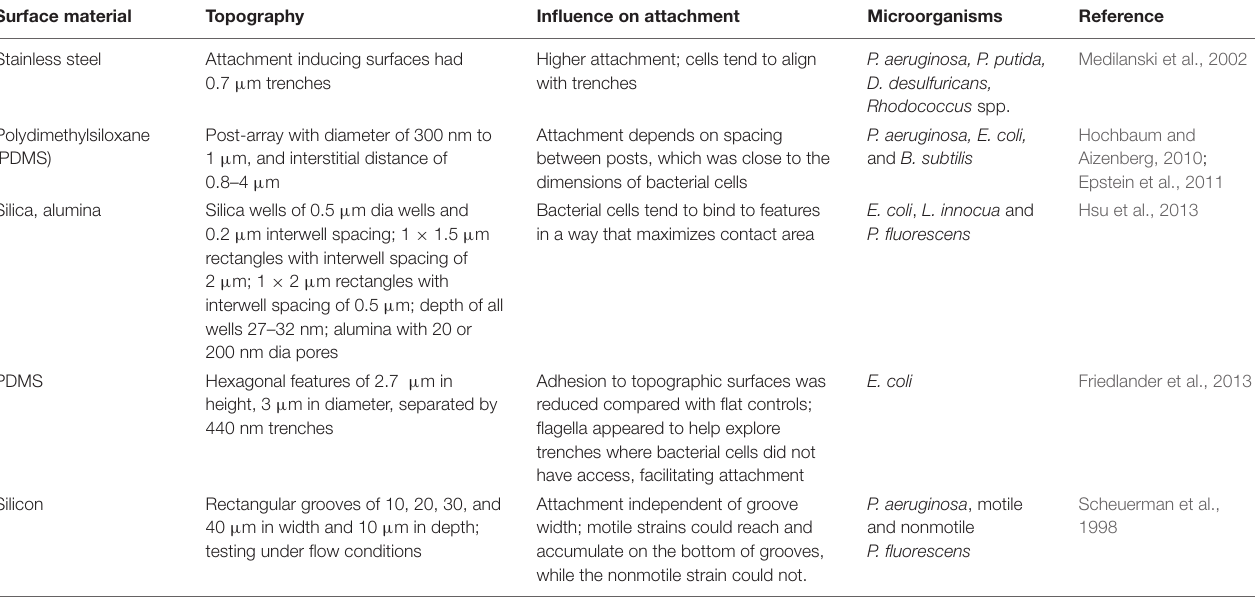
physicochemical forces ( Figure 2A ), cell membrane deformation ( Figure 2B ), chemical gradients at the solid-liquid